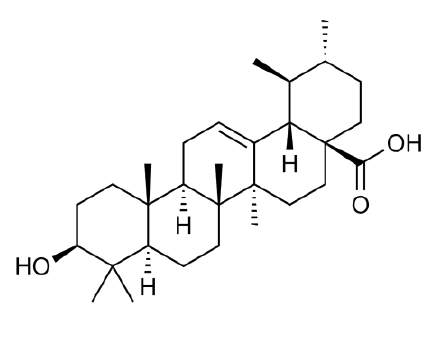
Figure 1. Structure of ursolic